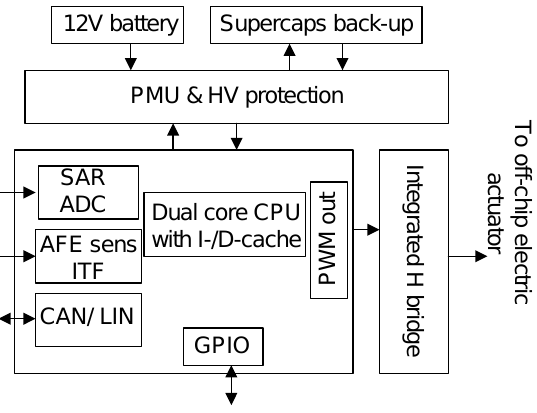
Figure 1. Architecture of the integrated mechatronic actuator control unit: low-voltage processing domain, high voltage power management, and H-bridge domain.